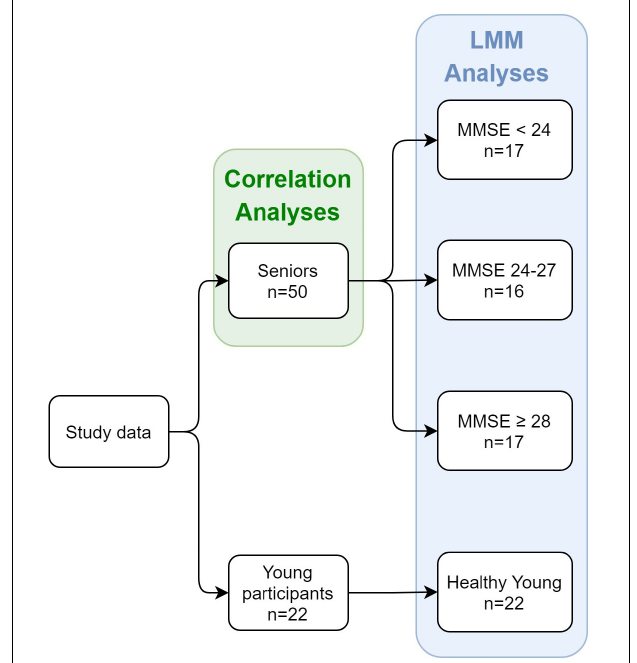
FIGURE 2 | Study design and groups at each stage. The study included both seniors and young healthy participants as controls. For the senior participants, an MMSE score was obtained, and division into groups was based on the individual MMSE